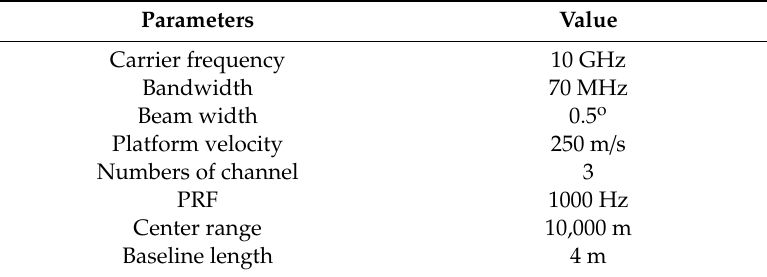
Table 1. Parameters of three-channel SAR-GMTI.